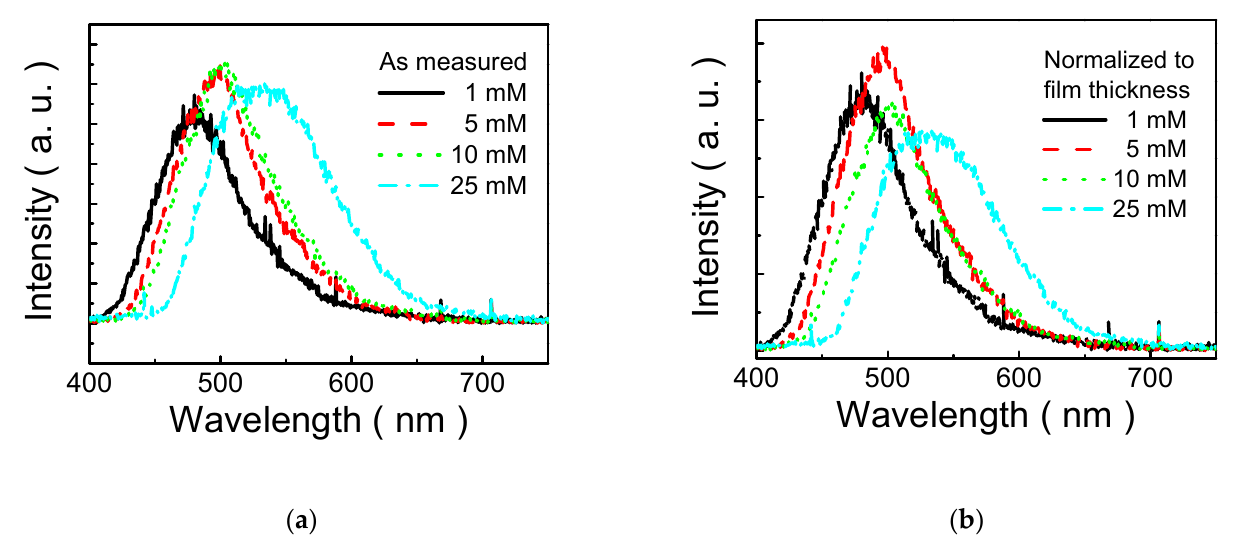
Figure 6. ( a ) PL spectra (original) of MP8B films prepared from various solutions (1, 5, 10, and 25 mM) and annealed at 80 °C; ( b ) PL spectra (normalized to thickness) of MP8B films prepared from various solutions (1, 5, 10, and 25 mM) and annealed at 80 ◦